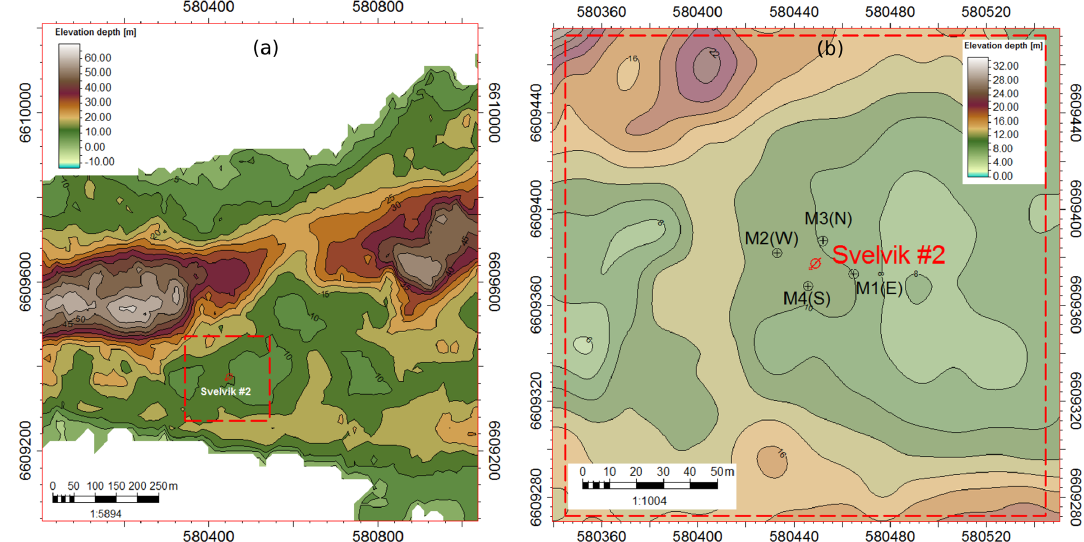
Figure 1. (a) Location of the Svelvik CO 2 Field Lab on the Svelvik ridge. (b) Detailed view of the test site with locations of the monitoring wells (M1–M4) and the injection well Svelvik #2.